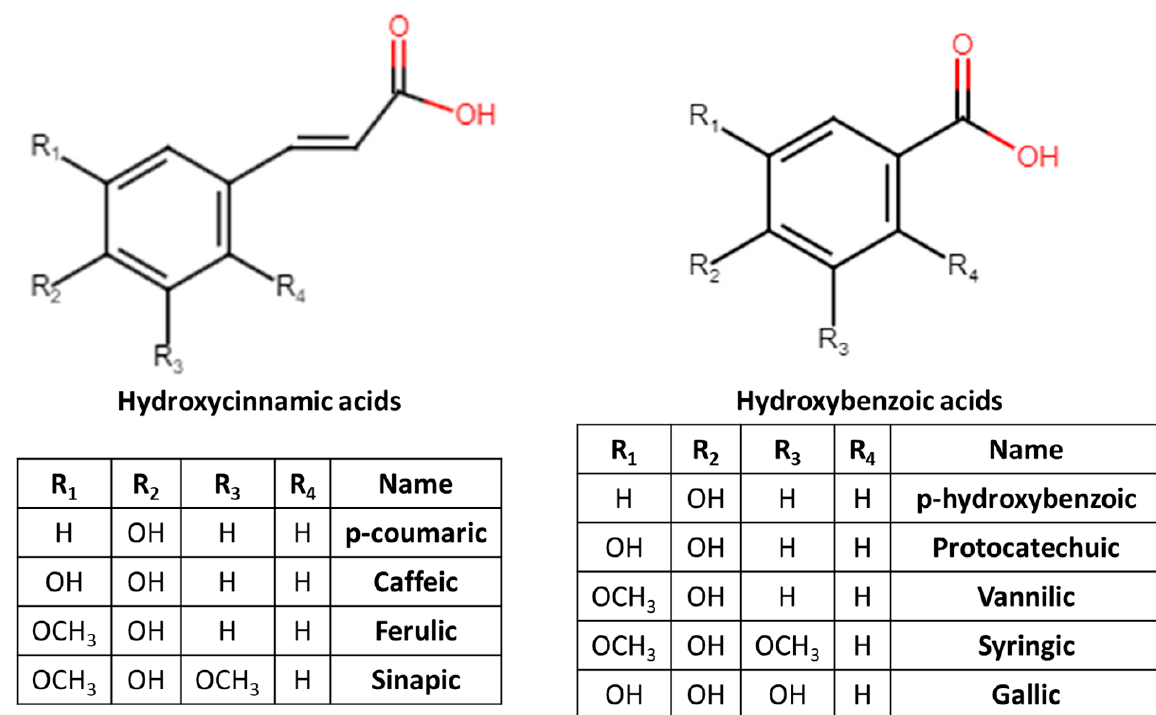
Figure 3. The major hydroxycinnamic and hydroxybenzoic acids.